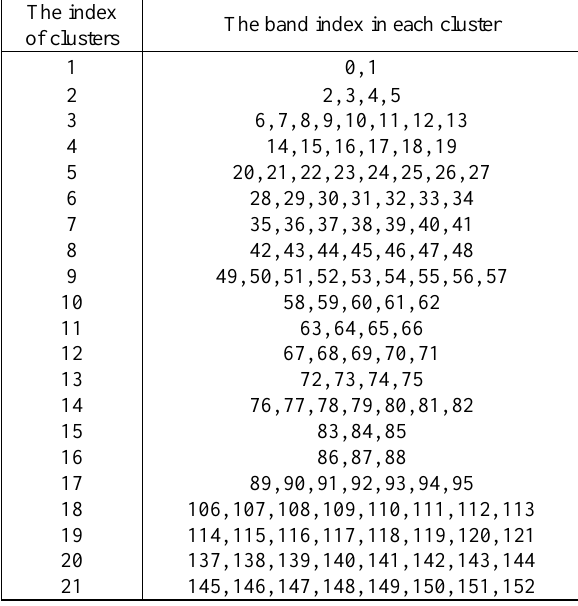
Table 1. The band cluster results of Markov